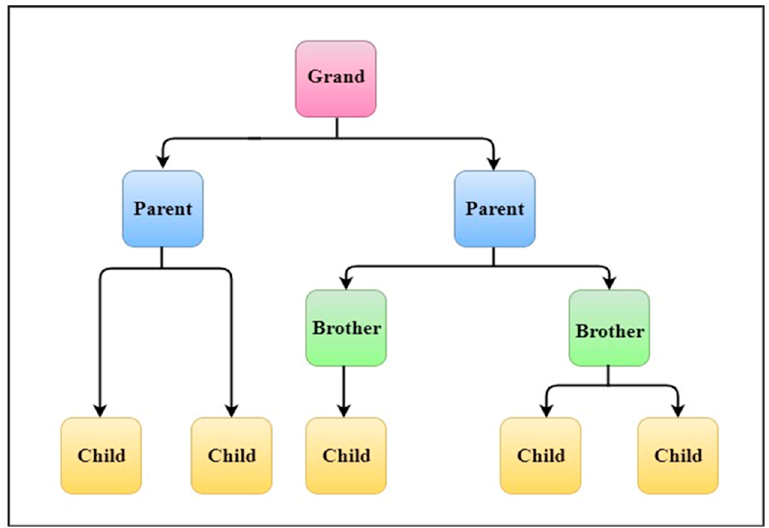
Figure 15. Sample of hierarchical clustering.